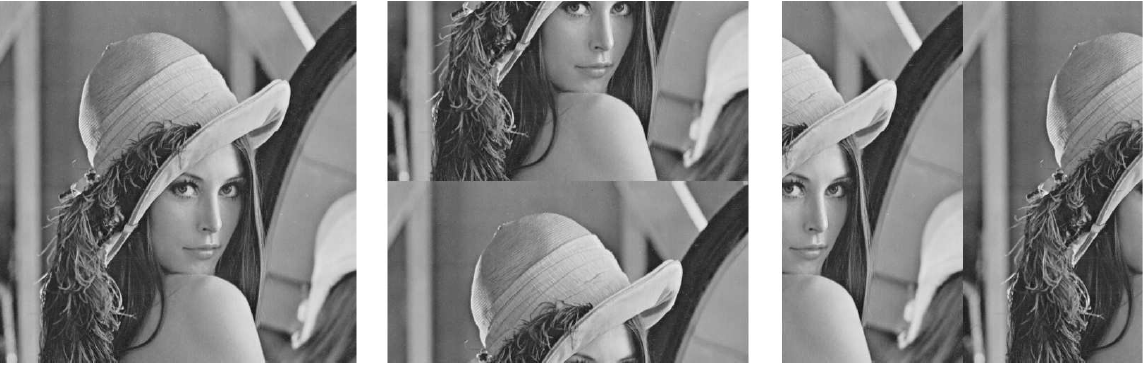
Figure 3. BMP test images.